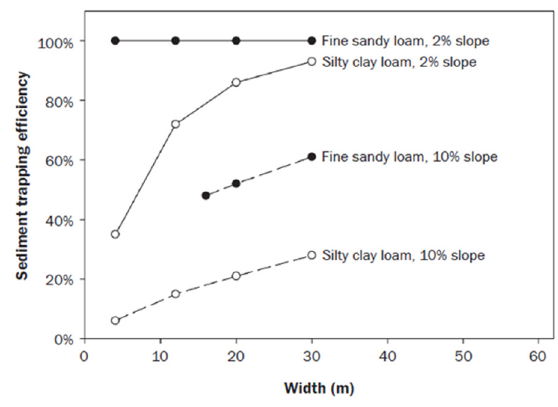
Fig. 1. Sediment trapping efficiency as a function of VFS width for two different sites having two different soil